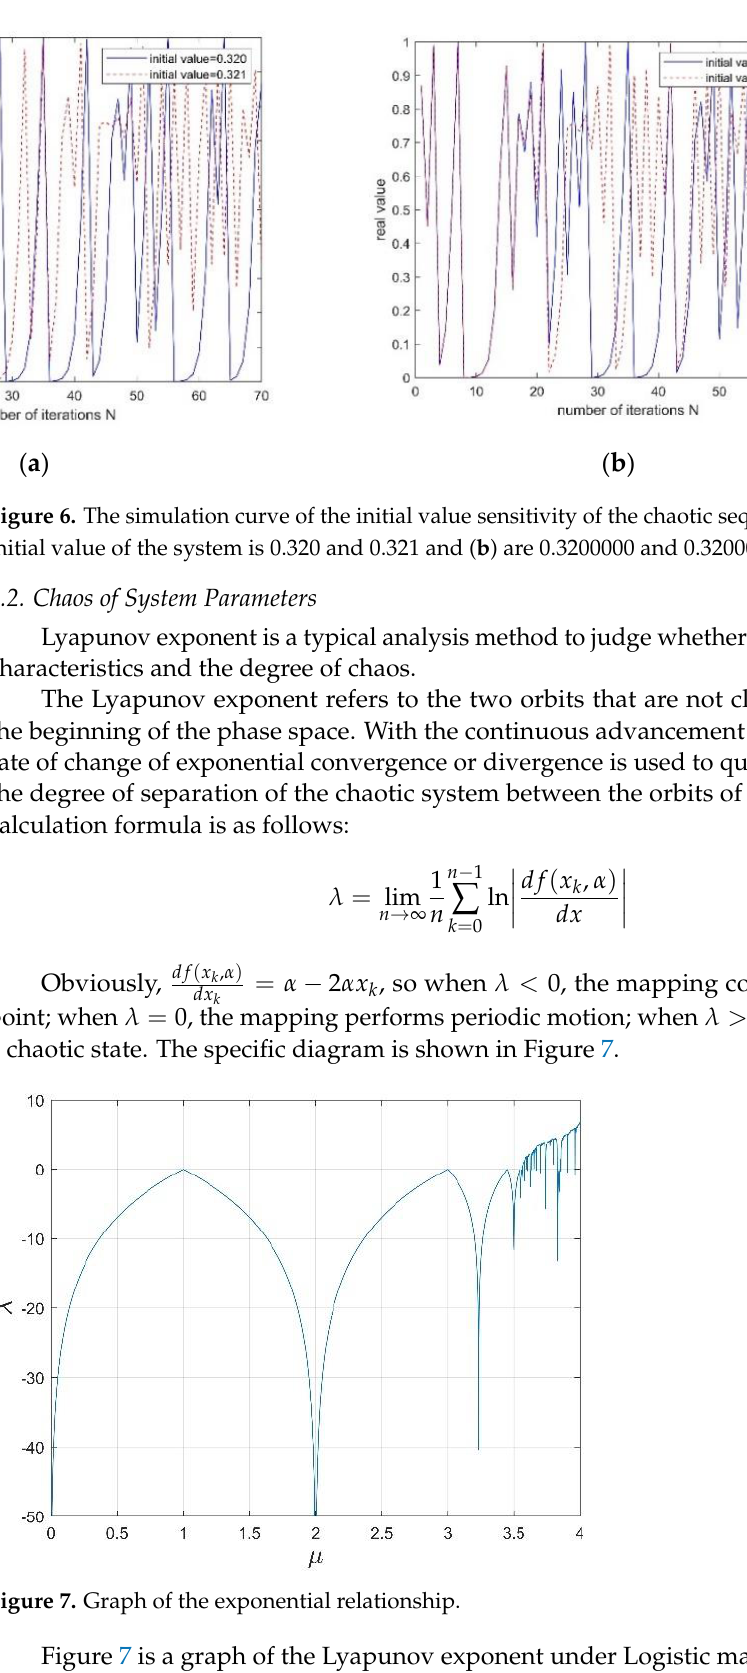
Figure 7. Graph of the exponential relationship.